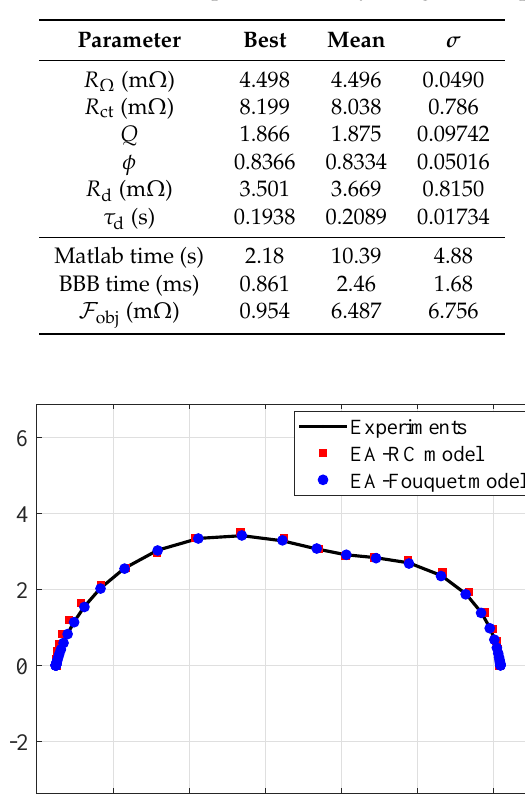
Table 2. Identification on Fouquet data [14] by using the Fouquet model.